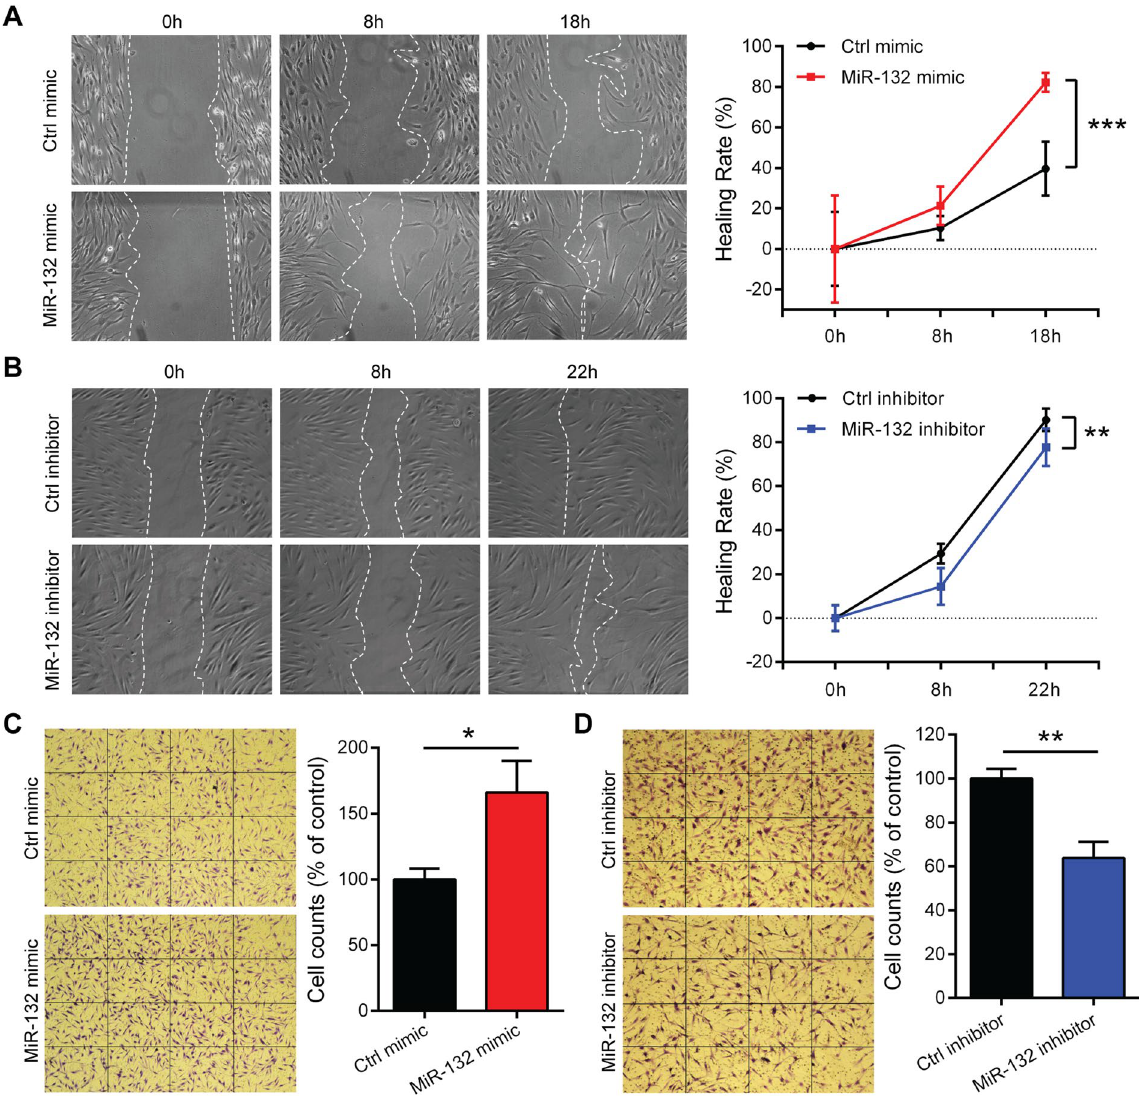
Figure 3. MiR-132 promotes fibroblast migration. Scratch assays were performed to assess the migration rate of HDFs transfected with 20 nM miR-132 mimics ( A ) or miR-132 inhibitors ( B ) for 48 hours. Photographs were taken at indicated time points after scratch injury. The healing rates were quantified by measuring the area of the injured region. ** P < 0.01 and *** P < 0.001 by Repeated Measures Two-way ANOVA. Transwell migration assay were performed to assess the motility of fibroblasts transfected with 20 nM miR-132 mimics ( C ) or miR- 132 inhibitors ( D ). The number of fibroblasts passing through the membrane within 24 hours was counted. * P < 0.05 and ** P < 0.01 by Student’s t-test. The data are presented as mean ±